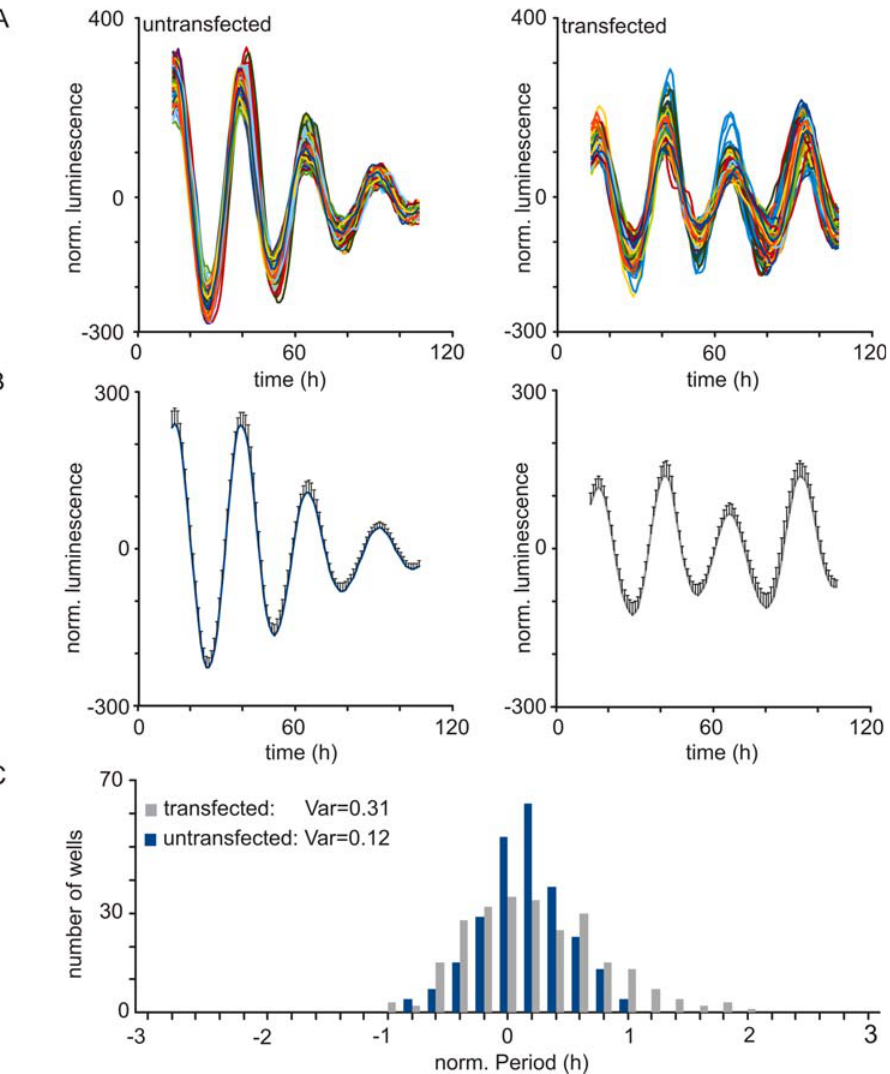
Figure 2. Effect of siRNA transfection on U2OS-B6 cells. (A) individual traces and (B) average (with s.d.) of detrended luminescence counts from wells with untransfected cells (left panel) or cells transfected with scrambled siRNA (right panel), n=250 per condition. (C) Frequency distribution of the period length of both untransfected cells and cells transfected with scrambled siRNA shown in (A) and (B).